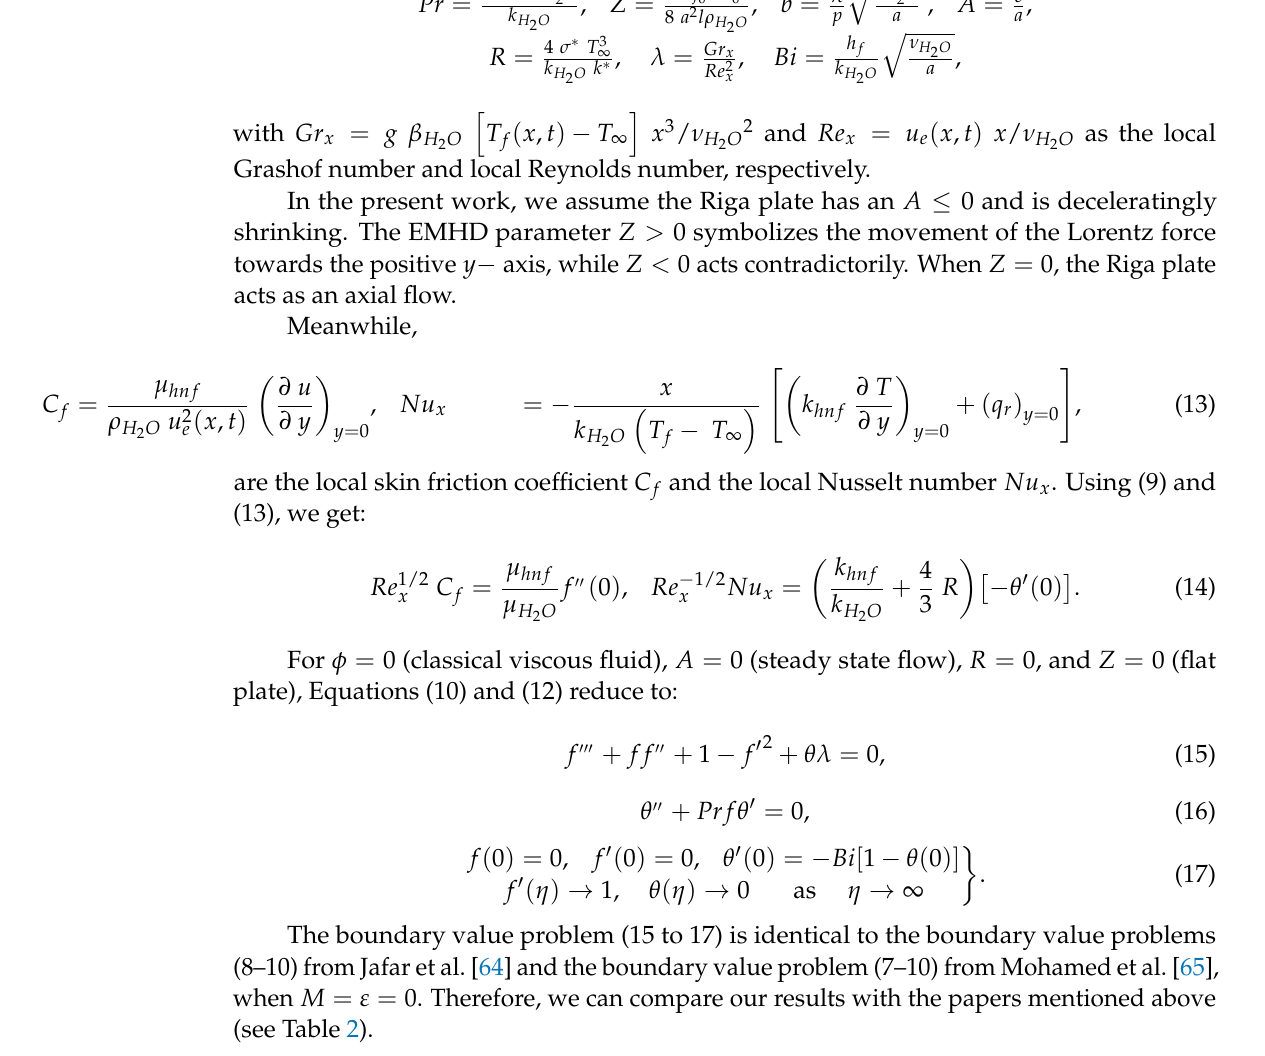
Table 2. Comparison of results with those by Jafar et al. [64] and Mohamed et al. [65].